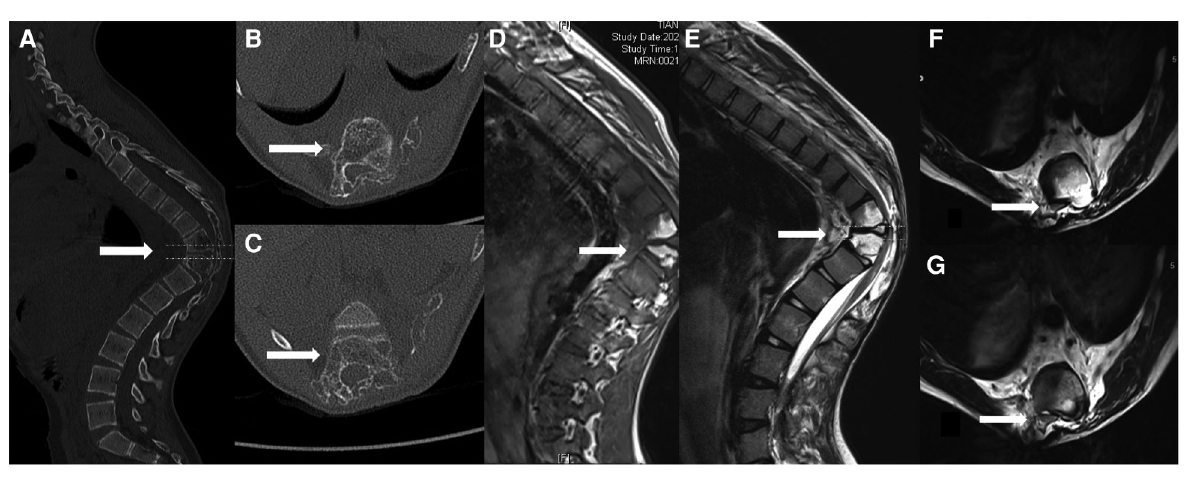
FIGURE 1 ( A ) Computed tomography images of the thoracic vertebrae indicate marked osteolysis within the T10/T11 vertebrae (arrows); ( B ) Osteolysis within the T10; ( C ) Osteolysis within the T11; ( D ) High-signal intensity was observed on the T1-weighted image within the T10/11 vertebrae (arrows); ( E ) High-signal intensity was observed on the T2-weighted image within the T10/11 vertebrae (arrows); ( F ) spinal cord compression was observed on the T2-weighted image within the T10 level (arrows); ( G ) spinal cord compression was observed on the T2-weighted image within the T11 level